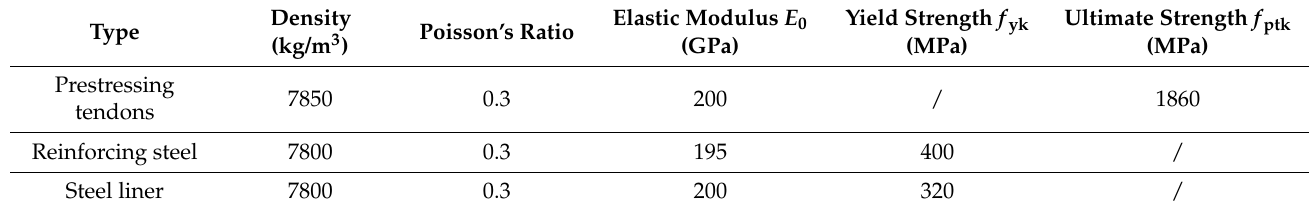
Table 4. The material property parameters of the steel